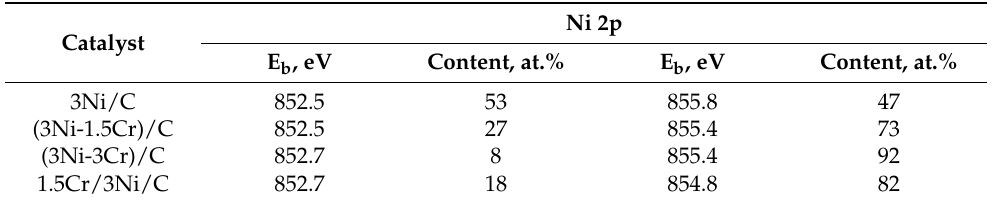
Table 1. The content of nickel in various degrees of oxidation on the surface of the studied samples according to the XPS data.